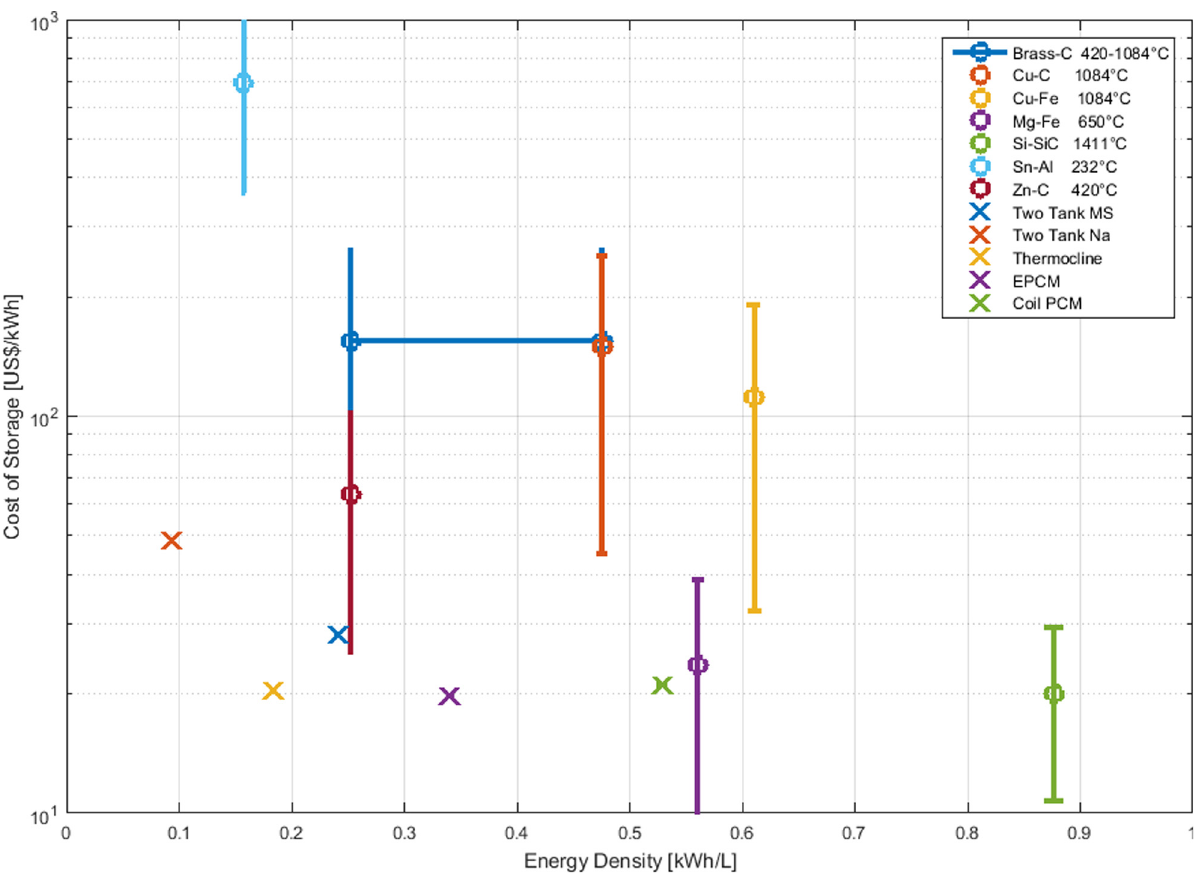
Fig. 2. Mean cost per unit energy of storage over the three different deployments for the seven different miscibility gap alloys, compared to state of the art thermal storage systems summarised in Table